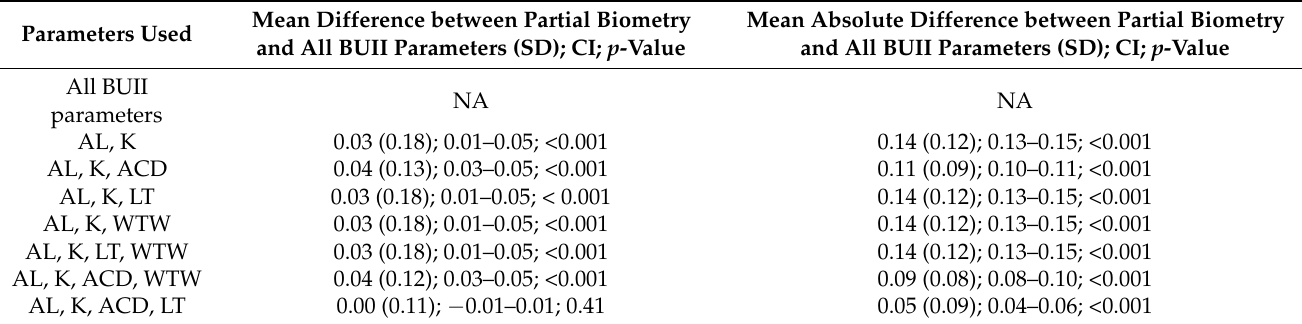
Table 2. The mean predicted IOL power results of all various